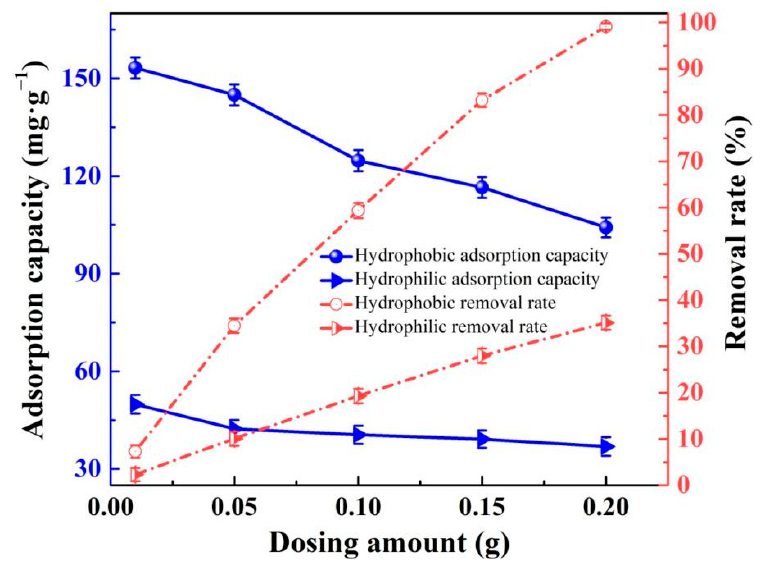
Figure 11. The adsorption capacities and removal rates of the hydrophilic and hydrophobic ZrO 2 -SiO 2 xerogels to RhB at various dosages (pH = 7, contact time = 120 min, RhB concentration = 140 mg · L − 1 ; T = 25 °C).